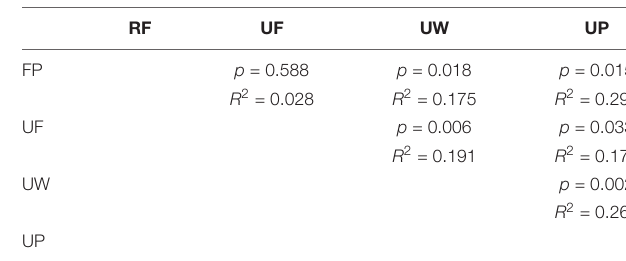
TABLE 3 | Summary of permutational multivariate analysis of variance examining soil mesofauna community structure difference among rural forest (RF), urban forest (UF), urban woodland (UW), and urban park